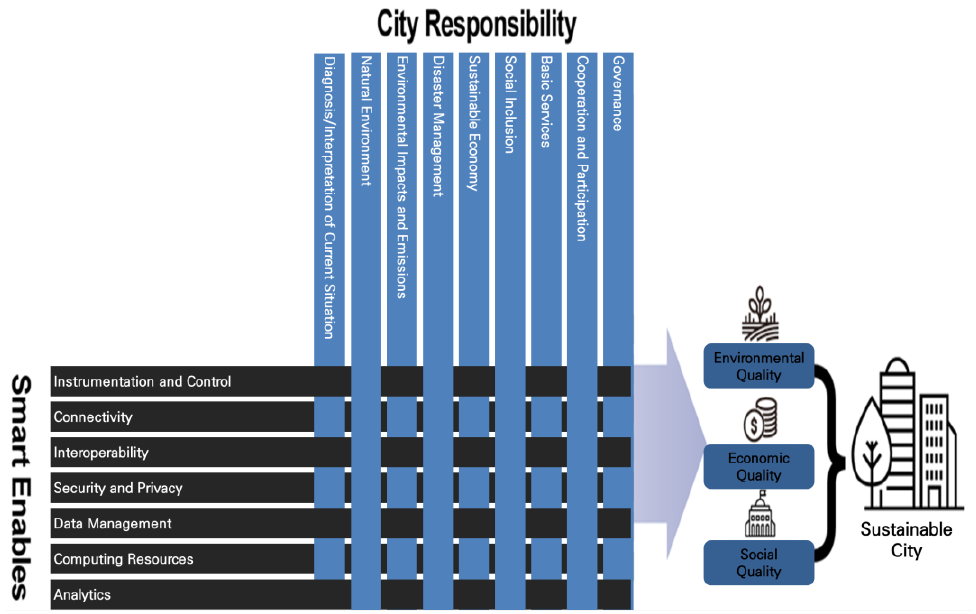
Figure 3. Smart sustainable city framework. Source: adopted from [57] based on [58].